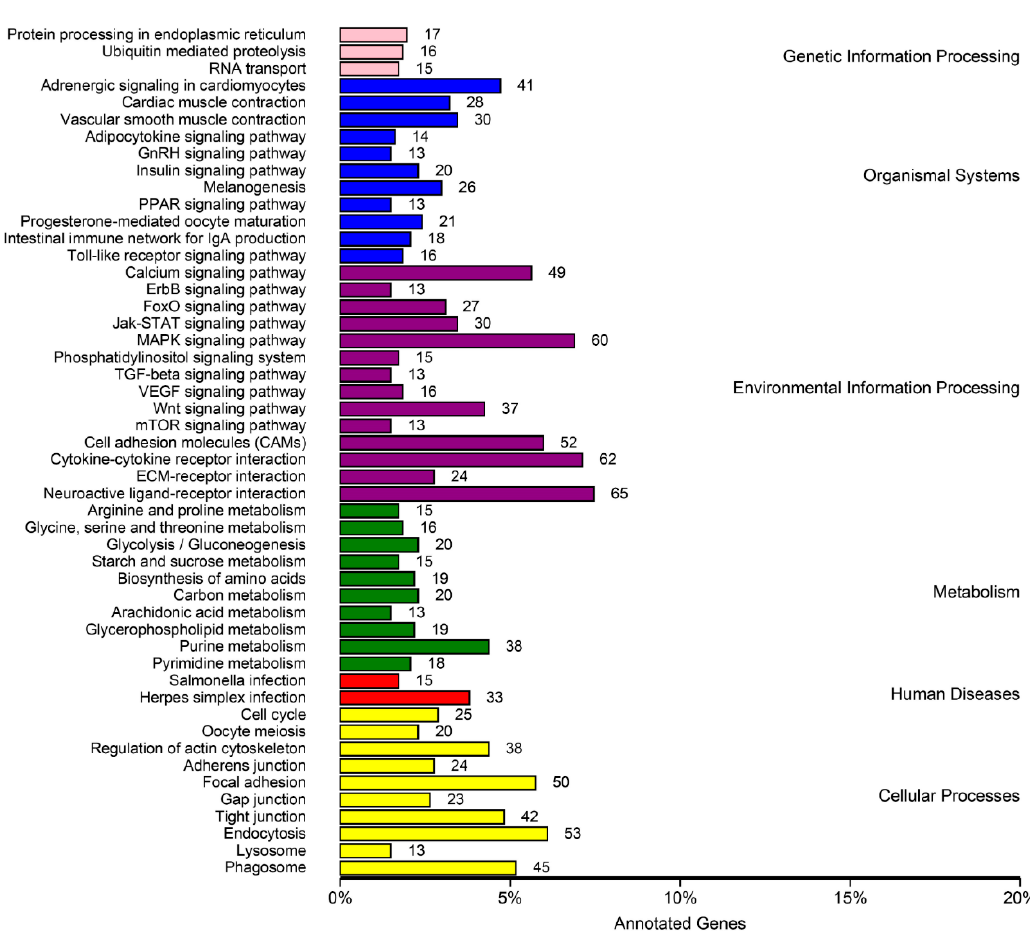
Figure 10. KEGG classifications of DEGs. The X-axis presents number and percentage of annotated DEGs; the Y-axis presents top 50 pathways.